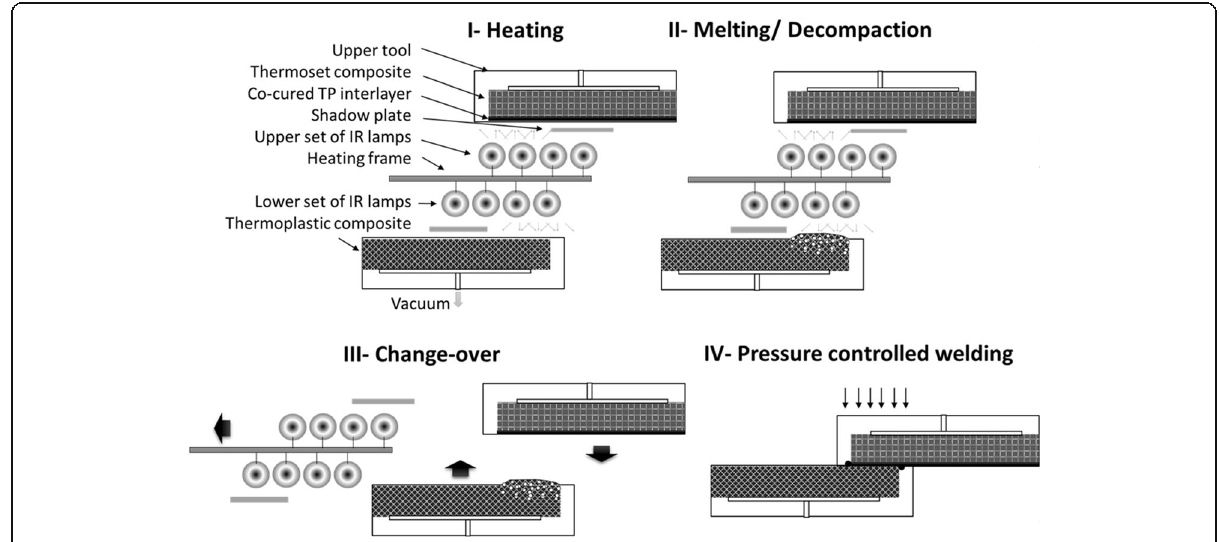
Fig. 4 Infrared welding process description for TSC/TPC welding